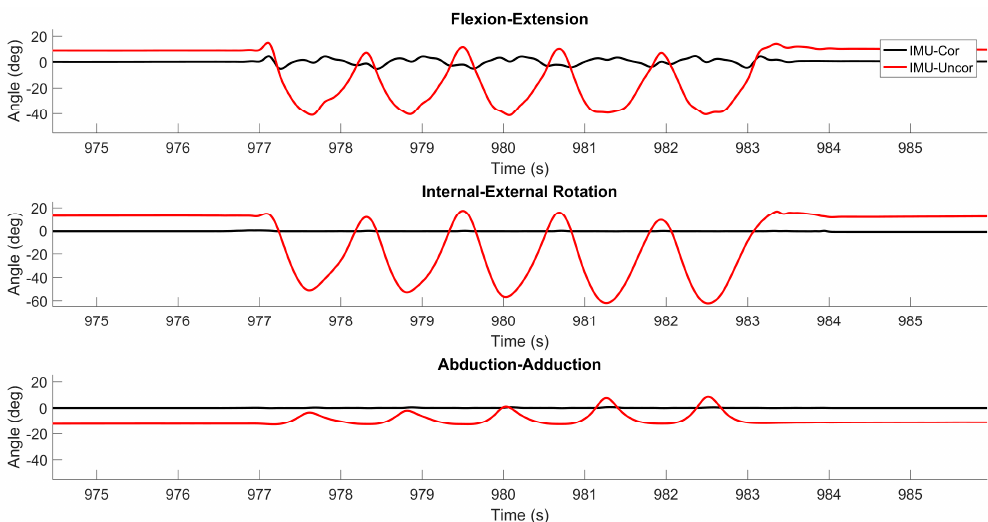
Figure 4. Example results from pure flexion/extension trial. The difference between CMM truth data and IMU-derived estimates with the correction (black) and without the correction (red) of flexion/extension, internal/external rotation, and abduction/adduction are plotted for a representative time period.